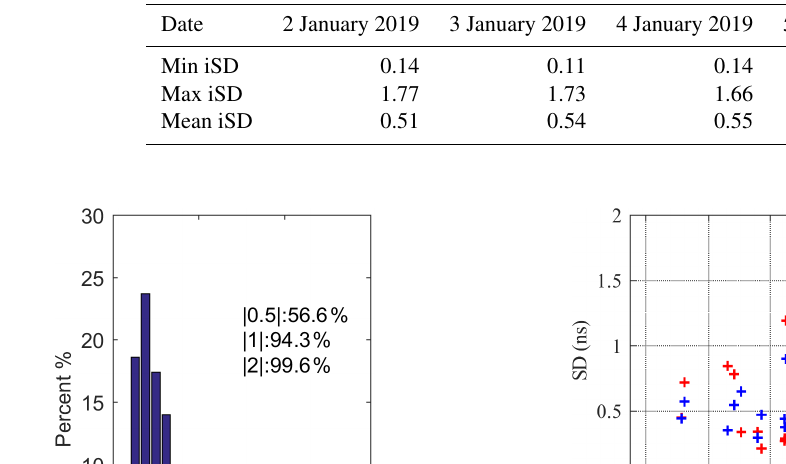
Table 2. Statistics of intraday SD of receiver DCB for all stations on 4 consecutive days.